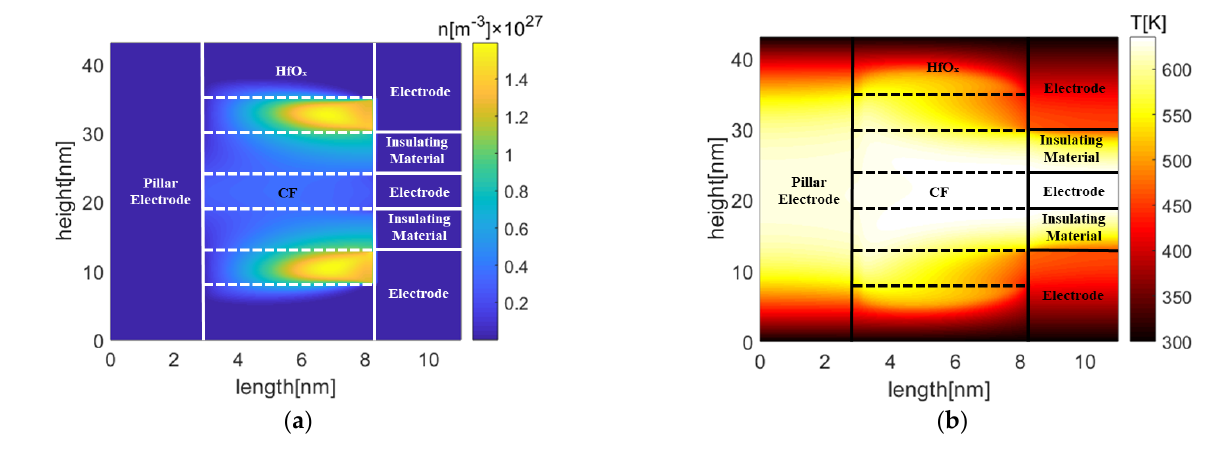
Figure 6. Distributions of ( a ) oxygen vacancy density and ( b ) temperature in Pt-RRAM. Both top and bottom cells are active, and captured at 0.2 s.